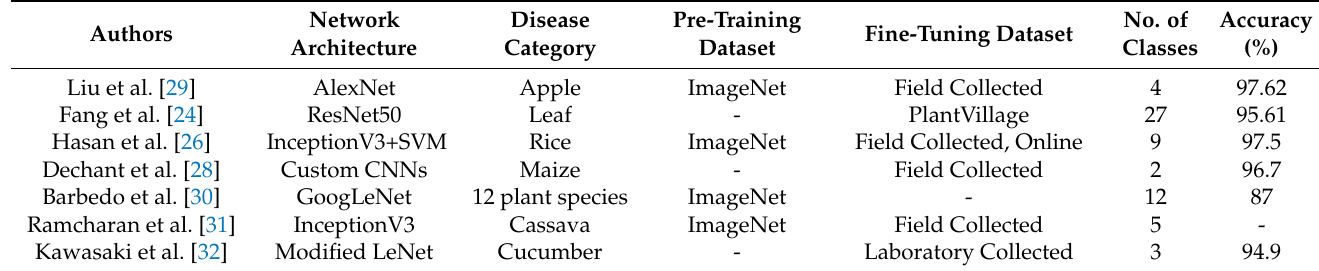
Table 1. Classification-based approaches for plant disease identification.